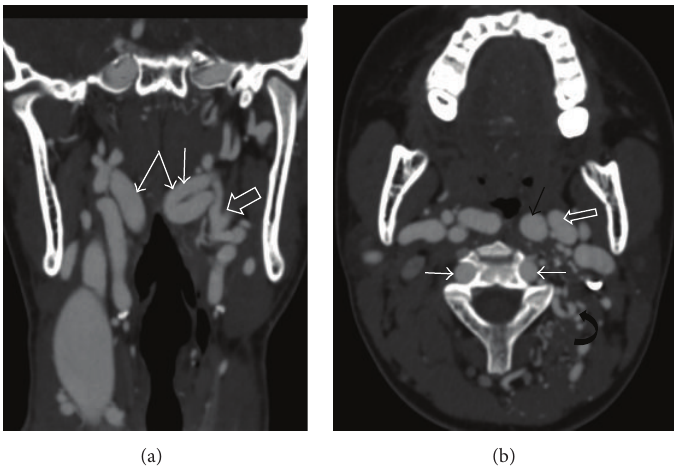
Figure 3: (a) Coronal MIP image showing dilatation and tortuosity of left ICA (single white arrow) and ECA (open arrow) and kissing carotids (white arrows). (b) Axial MIP image at the level of bifurcation of CCA showing dilated left ICA (black arrow), ECA (open arrow) with multiple inter and intramuscular arterial collaterals on left side of neck (curved arrow), and prominent vertebral arteries (white